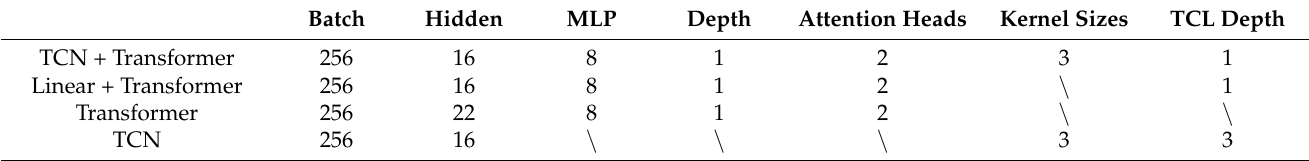
Table 3. Parameter setting of TCN and Transformer.